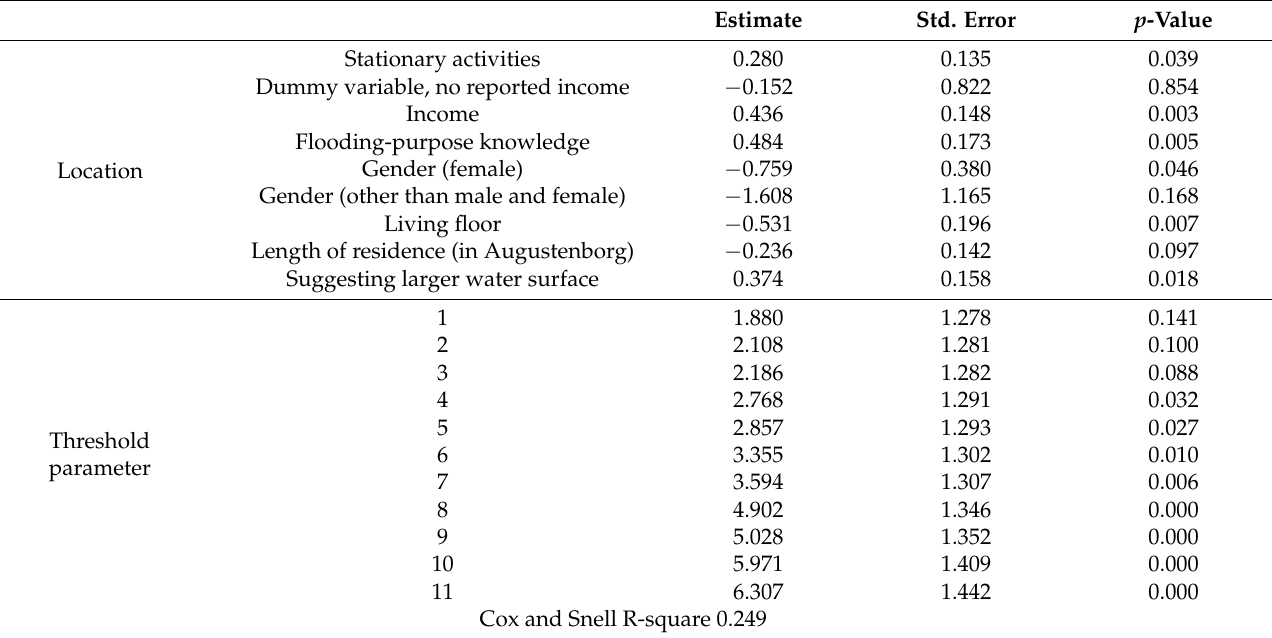
Table 5. The parameter estimates of the ordered logit model for WTP for living in a neighborhood with BGS.